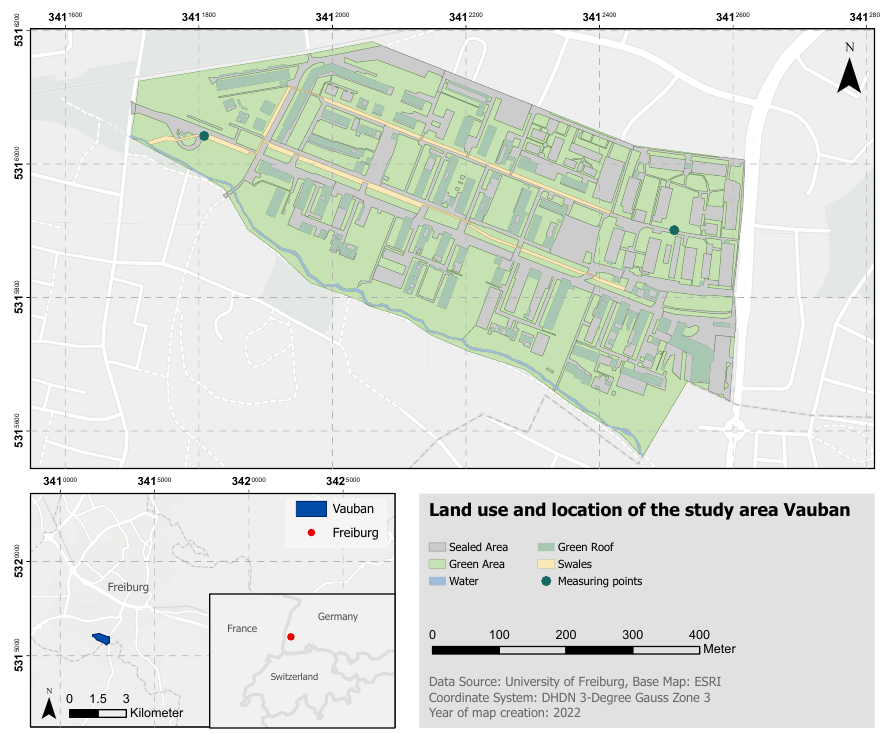
Figure 1. Land use and location of the study area